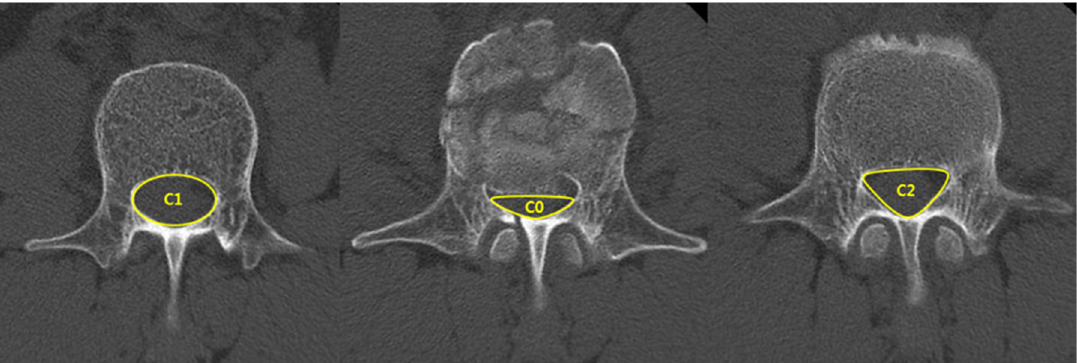
Figure 2. The spinal canal compromise (SCC) is calculated as a ratio of the canal area of the injured level to the average of that of the two adjacent intact segments.; SCC = ((C1 + C2) − 2C0)/(C1 + C2) × 100%.